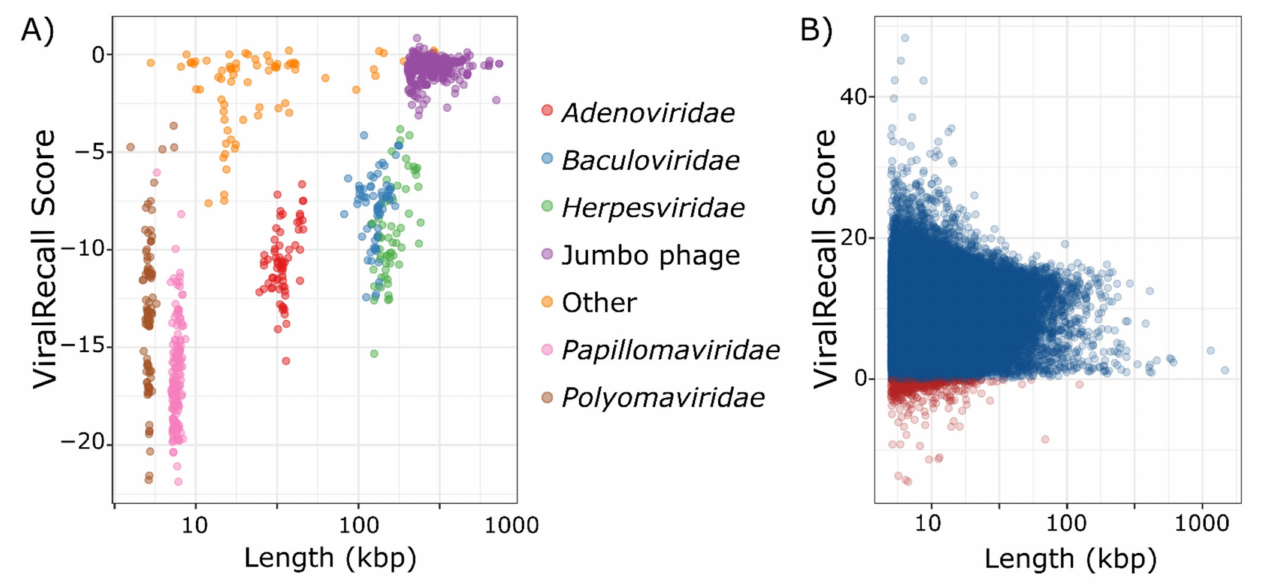
Figure 2. ( A ) ViralRecall scores and lengths for 879 non-nucleocytoplasmic large DNA viruses (NCLDV) dsDNA viruses. ( B ) ViralRecall scores and lengths for 38,886 giant virus contigs from 1548 reference and metagenome-assembled giant virus genomes. Contigs with scores <0 are colored red, while those with scores ≥ 0 are colored